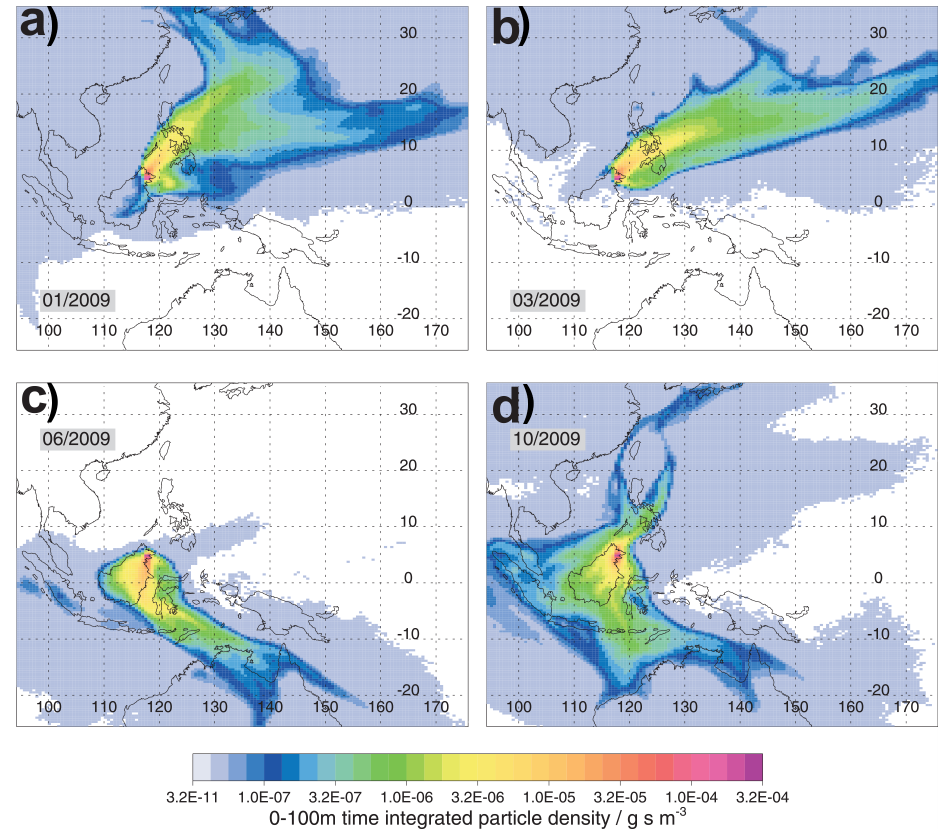
Figure 6. Air history maps for 2009 for Bukit Atur for selected months: (a) January, (b) March, (c) June and (d) October. Maps for all months were produced but not shown. Each map is compiled from 11000 particles released on an hourly basis by the NAME dispersion model using UK Met Office analysed wind fields at ∼ 50km horizontal resolution. They show the particle density in the lowest 100m averaged over the preceding 12 days. From November to February the air mass origin is mainly from the Northern Hemisphere, often passing close to China (a) . Between March and May the air mass origin gradually changes towards western Pacific equatorial latitudes, away from large urban regions (b) . From June to September the air mass history is influenced from the region to the southeast, characterised by Southern Hemisphere air, with sparse anthropogenic emissions (c) . October sees a transition back to Northern Hemisphere air masses (d)